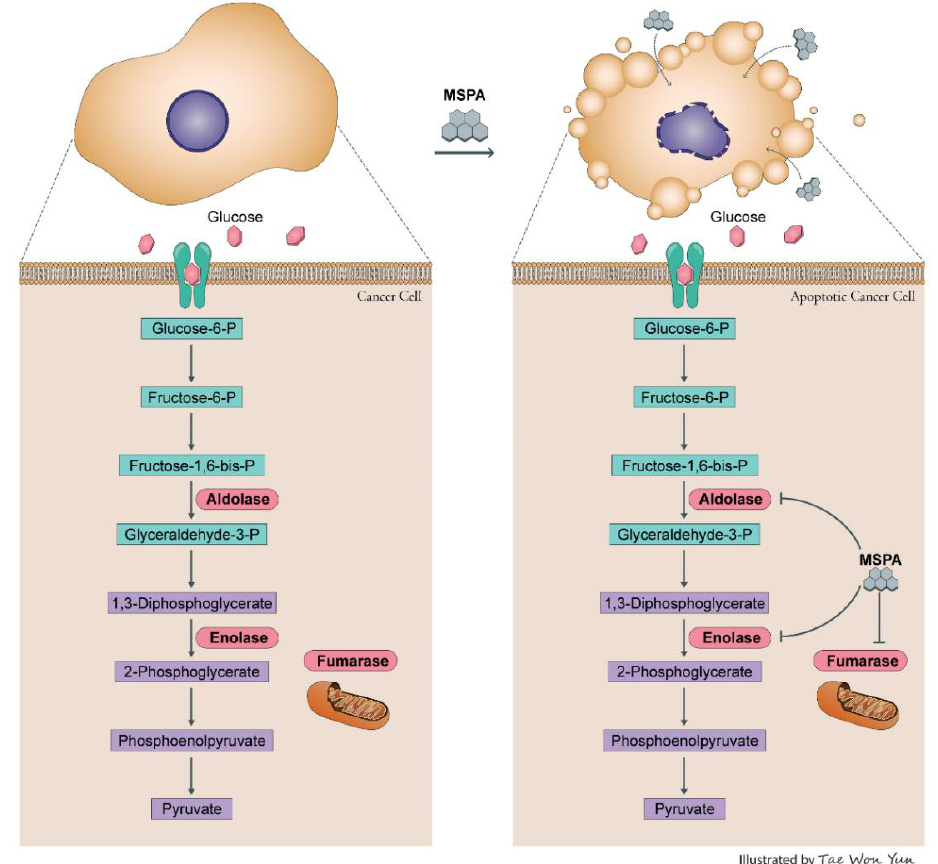
Figure 6. A schematic representation of the molecular mechanisms of MSPA activity; the compound inhibits cancer cell proliferation by targeting ALDOA , ENO1 , and FH .